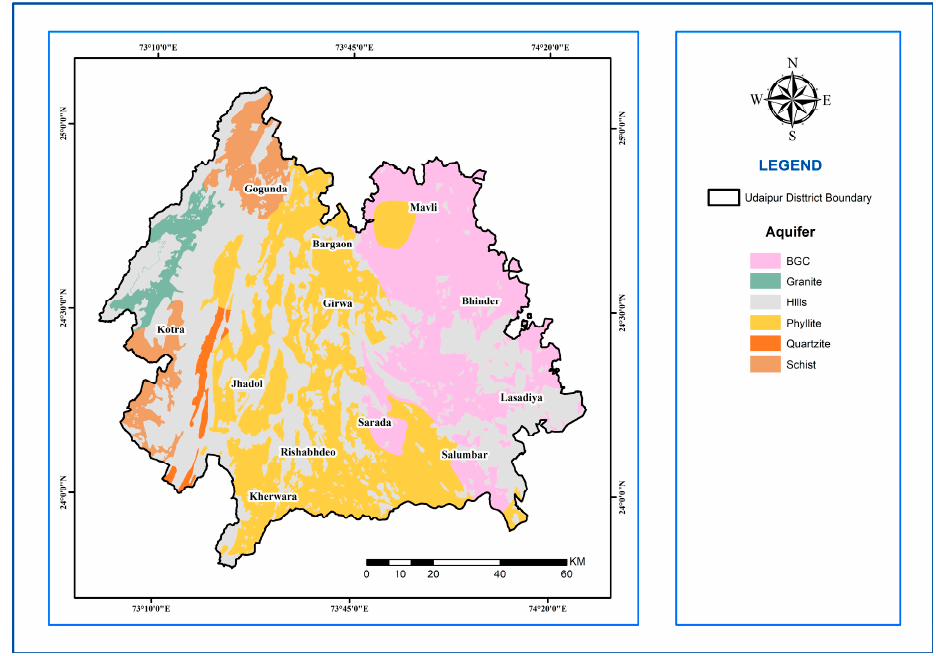
Figure 8. The distribution of different lithologies in the Udaipur district.